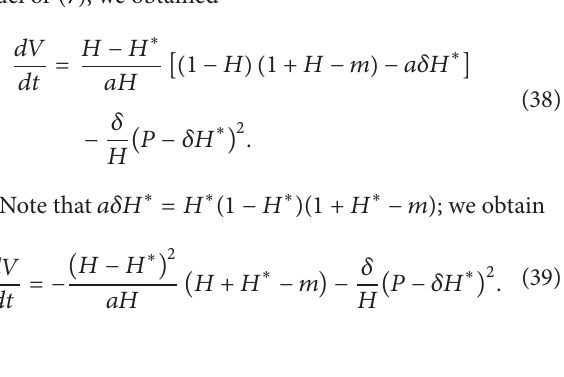
Substituting the value of 𝑑𝐻/𝑑𝑡 and 𝑑𝑃/𝑑𝑡 from the model of (7), we obtained